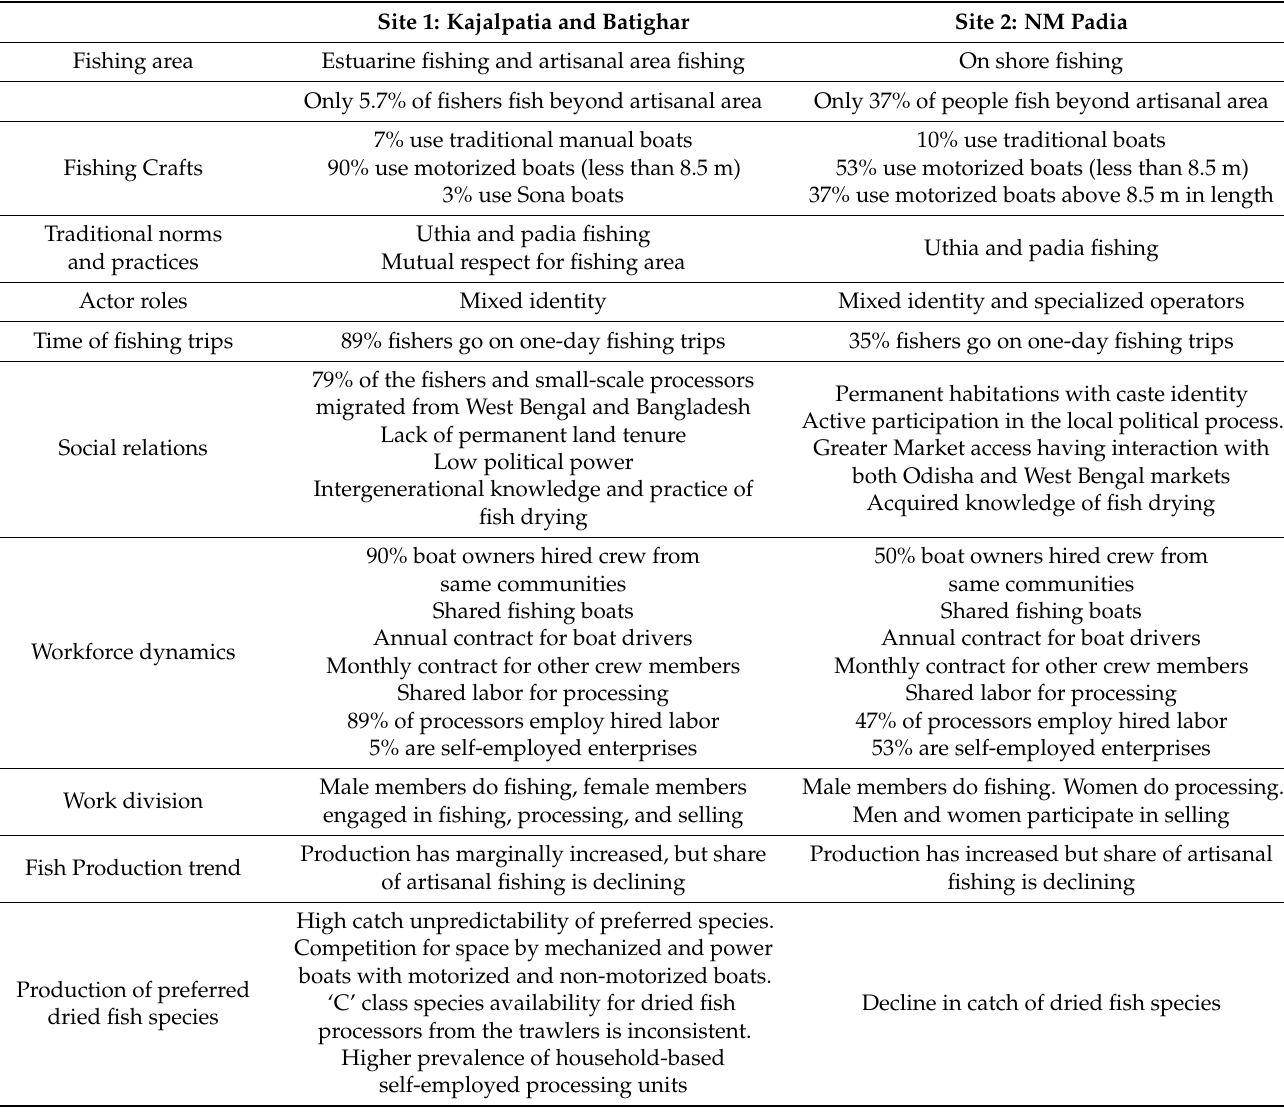
Table 1. Key characteristics of study location. Site 1: Kajalpatia and Batighar Site 2: NM